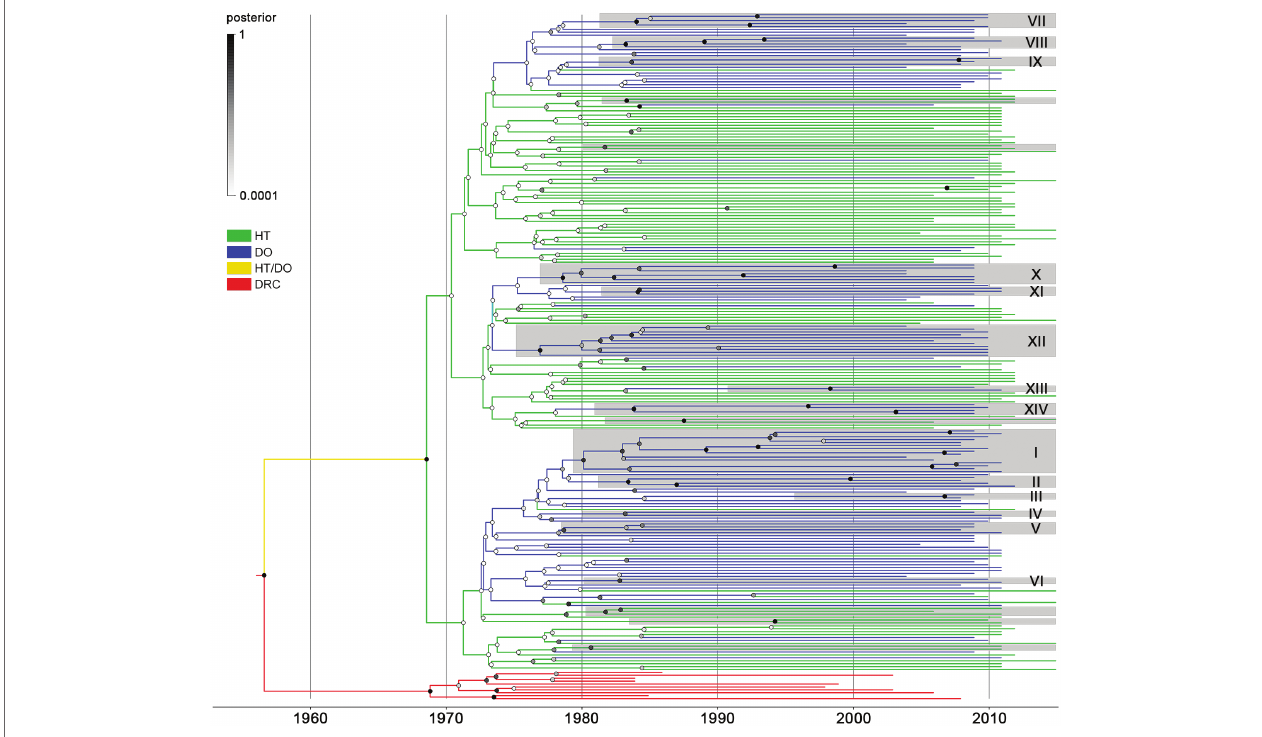
FIGURE 2 | Spatiotemporal dissemination of HIV-1 B CAR lineages in Hispaniola. Time-scaled Bayesian MCC tree of HIV-1 B CAR pol sequences from Haiti ( n = 103) and the Dominican Republic ( n = 123) combined with subtype D reference sequences from the Democratic Republic of Congo (DRC; n = 10). Branches are colored according to the most probable location state of their descendent nodes as indicated in the legend on the left. Shaded boxes highlight the position of B CAR clades only composed by sequences from Haiti or the Dominican Republic (identified by numbers) and that displayed both high clade (PP ≥ 0.70) and location state (PSP ≥ 0.90) node supports. Circles at internal nodes are colored according to the corresponding PP node support as indicated in the legend on the left. Branch lengths are depicted in units of time (years). The tree was rooted under the assumption of a relaxed molecular